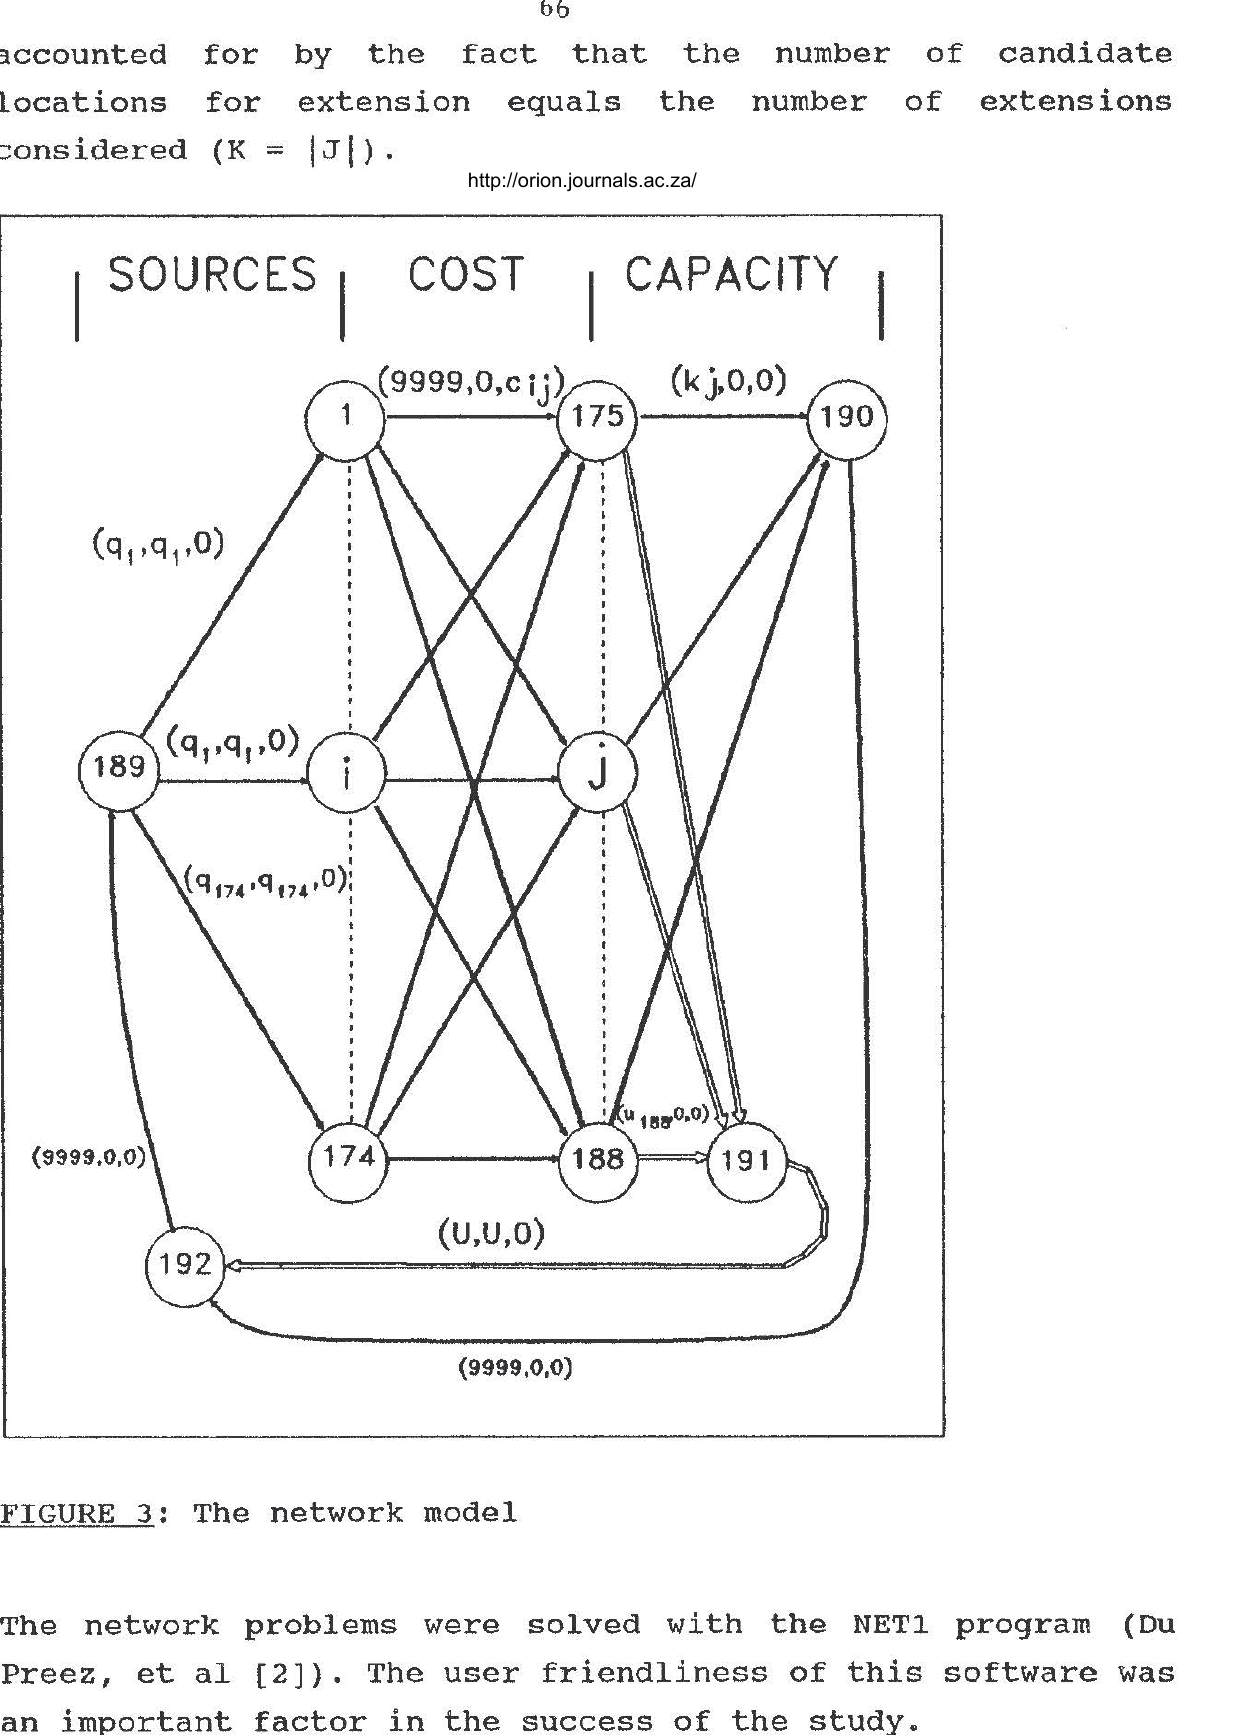
FIGURE 3: The network